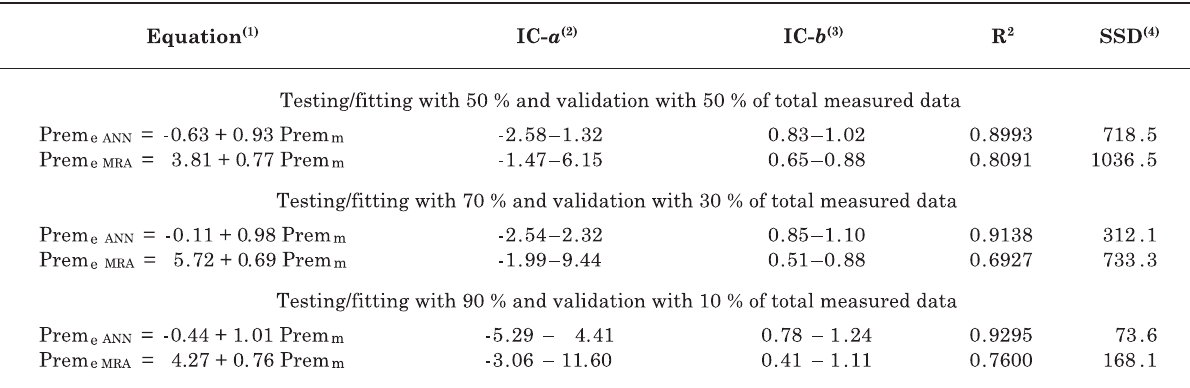
Table 3. Results of the simple linear regression analyses relating measured remaining phosphorus (Prem with estimated values (Prem ) based on pedotransfer functions developed by artificial neural networks e (ANN) and by multiple regression analysis